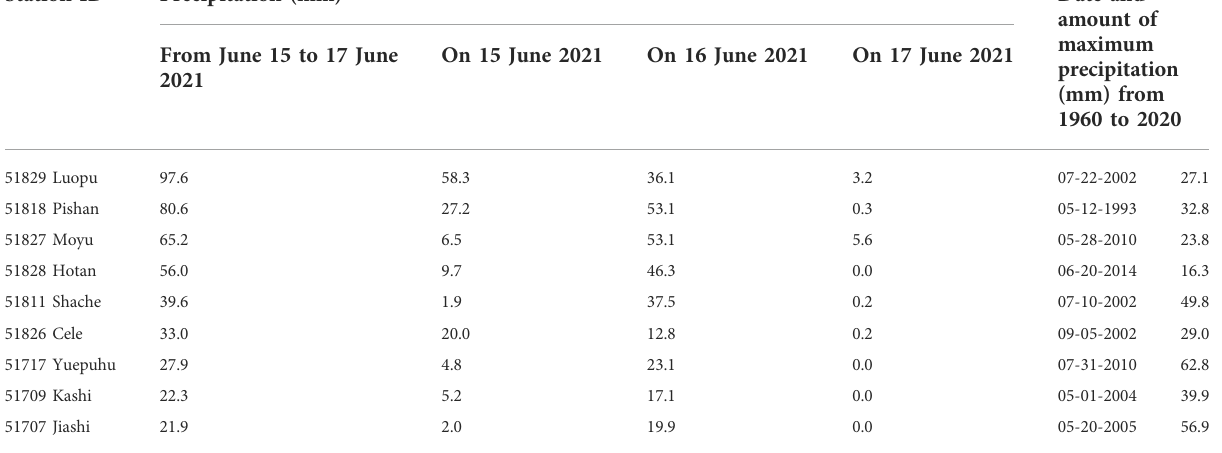
TABLE 2 Precipitation from June 15 to 17 June 2021, at weather stations in Hotan and Kashgar region. Station ID